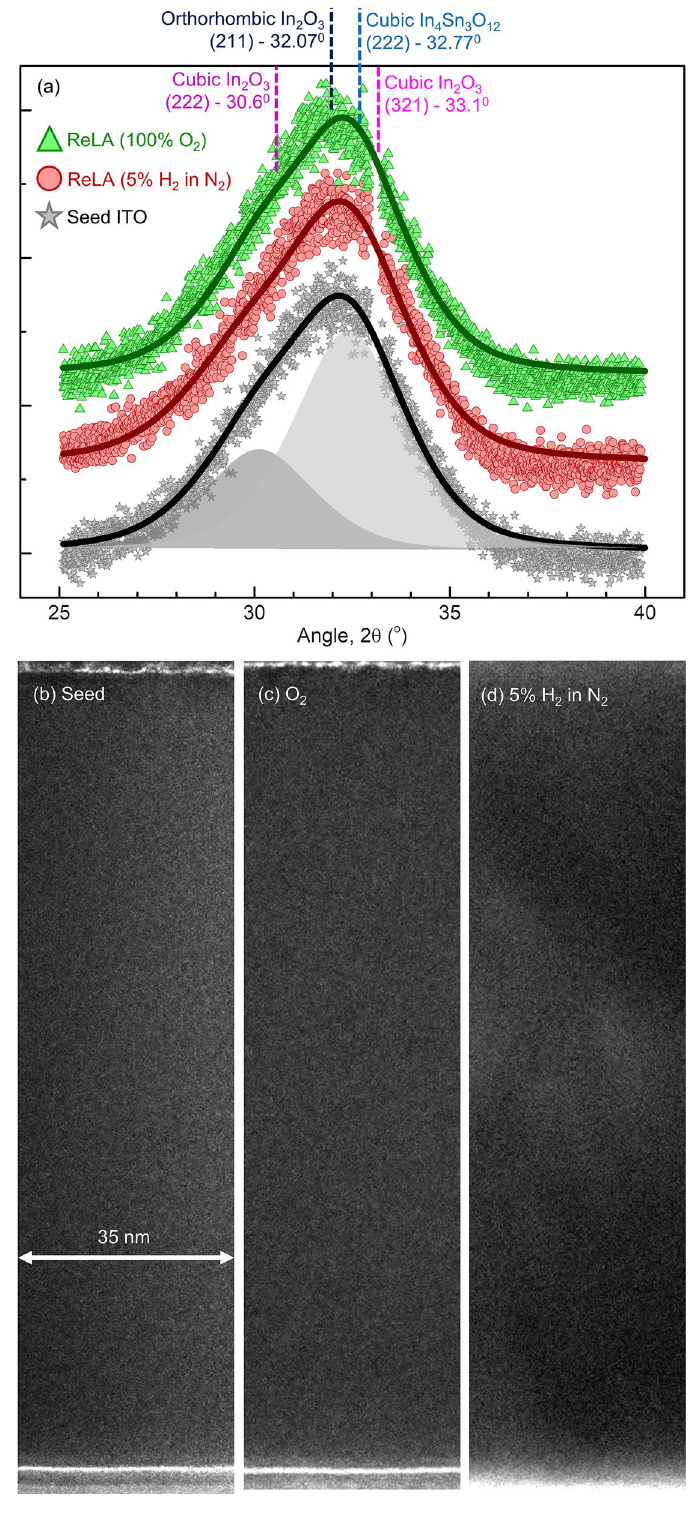
Figure 3. Structural properties of seed ITO films and laser processed at 125 mJcm − 2 . X-ray diffractograms for seed ITO film (grey stars) and those subject to ReLA in 5% H 2 in N 2 (red circles) and 100% O 2 (green triangles) at 125 mJcm − 2 . The solid black, red, and green lines represent the corresponding fit of two pseudo-Voigt functions to the data. For the seed film, we present the component peaks, representing cubic In 2 O 3 ( 222 ) and rhombohedral In 4 Sn 2 O 12 , with the grey shaded areas. The sharp ( 200 ) Si peak at 32.9 ◦ − 33.1 ◦ has been manually removed from all diffractograms. Also shown are the TEM cross-sectional images of the ( b ) seed ITO film and those subject to ReLA at 125 mJcm − 2 in ( c ) 100% O 2 and ( d ) 5% H 2 in N 2